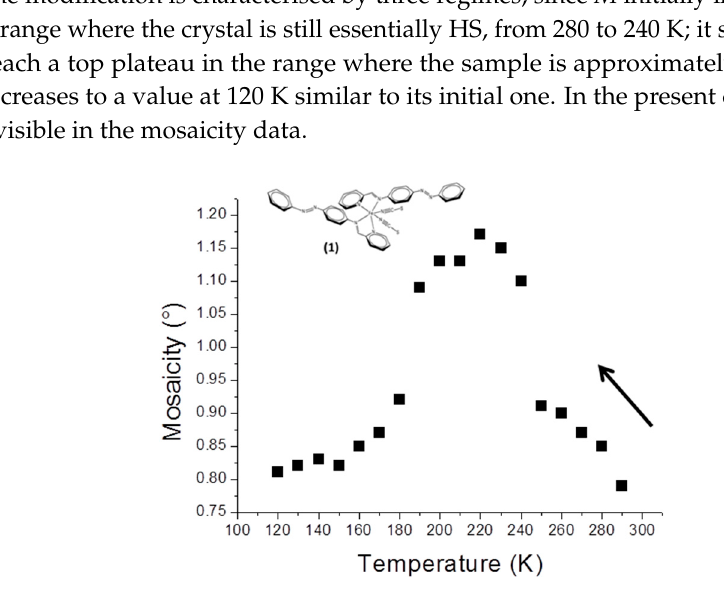
Figure 1. Temperature dependence of the mosaicity for a small crystal of [Fe(PM-AzA) 2 (NCS) 2 ] in the cooling mode.